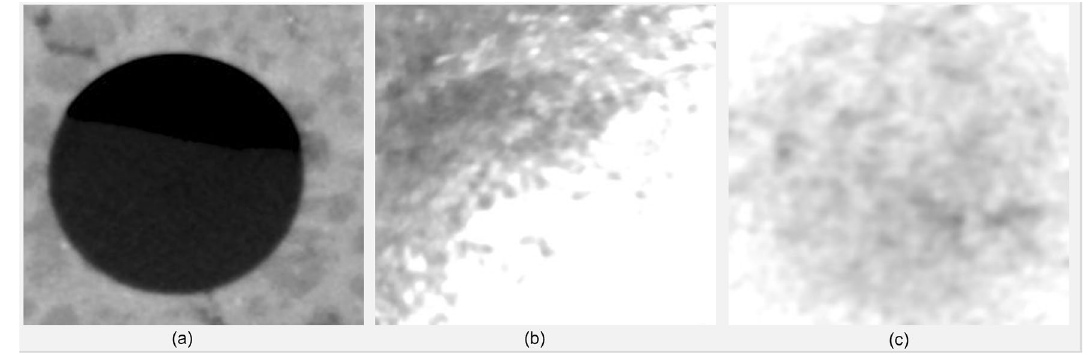
Fig. 3 2D image slices with: a missing CT values (due to rush plugs), b high-density material (cementation or drilling mud invasion), and c core barrel